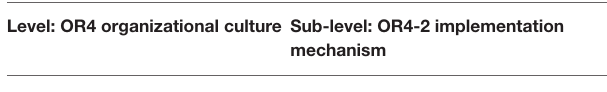
TABLE 3 | Organization – the level of preparation contents. Level: OR1 infrastructure connectivity